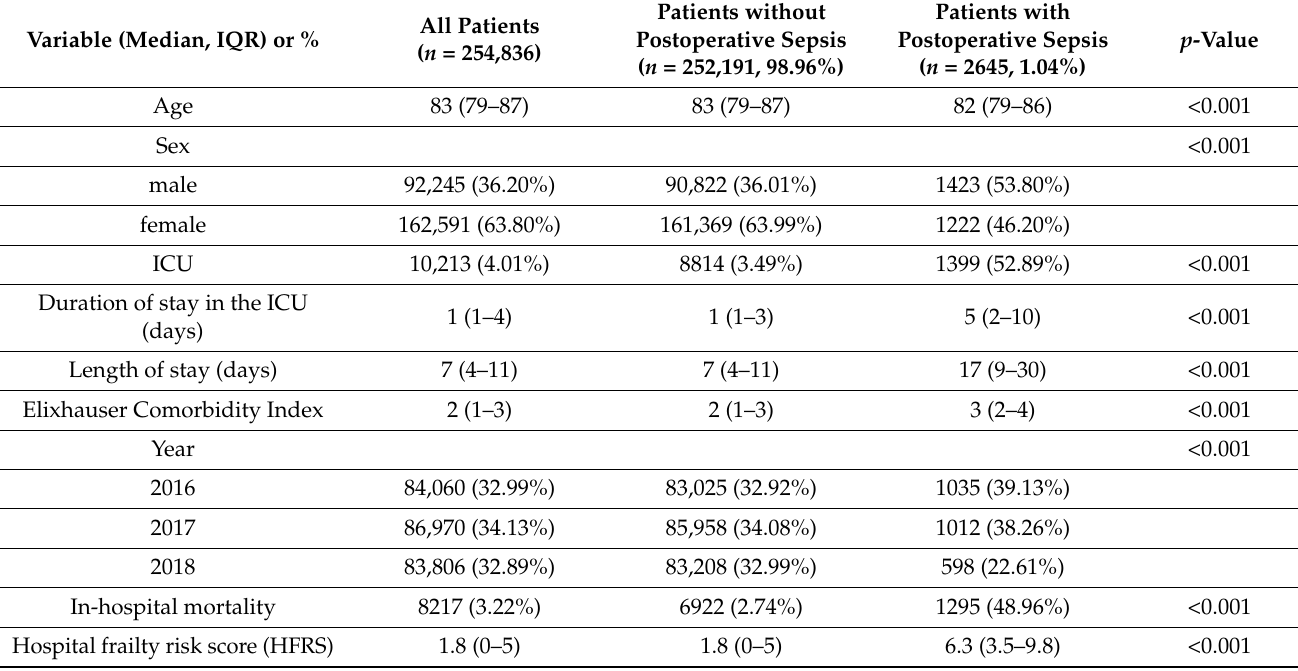
Table 1. General characteristics of the patients analyzed in the study ( n = 254,836) and of the patients with incidence of postoperative sepsis population ( n =